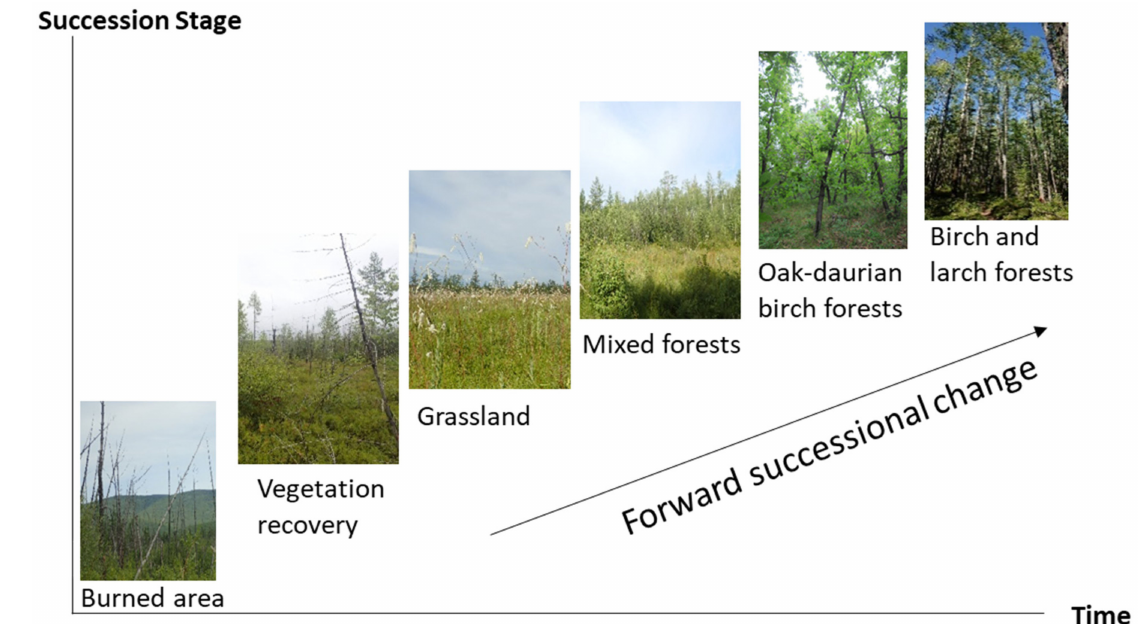
Figure 11. Typical forest successional gradient after forest fire disturbance on Zeya State Nature